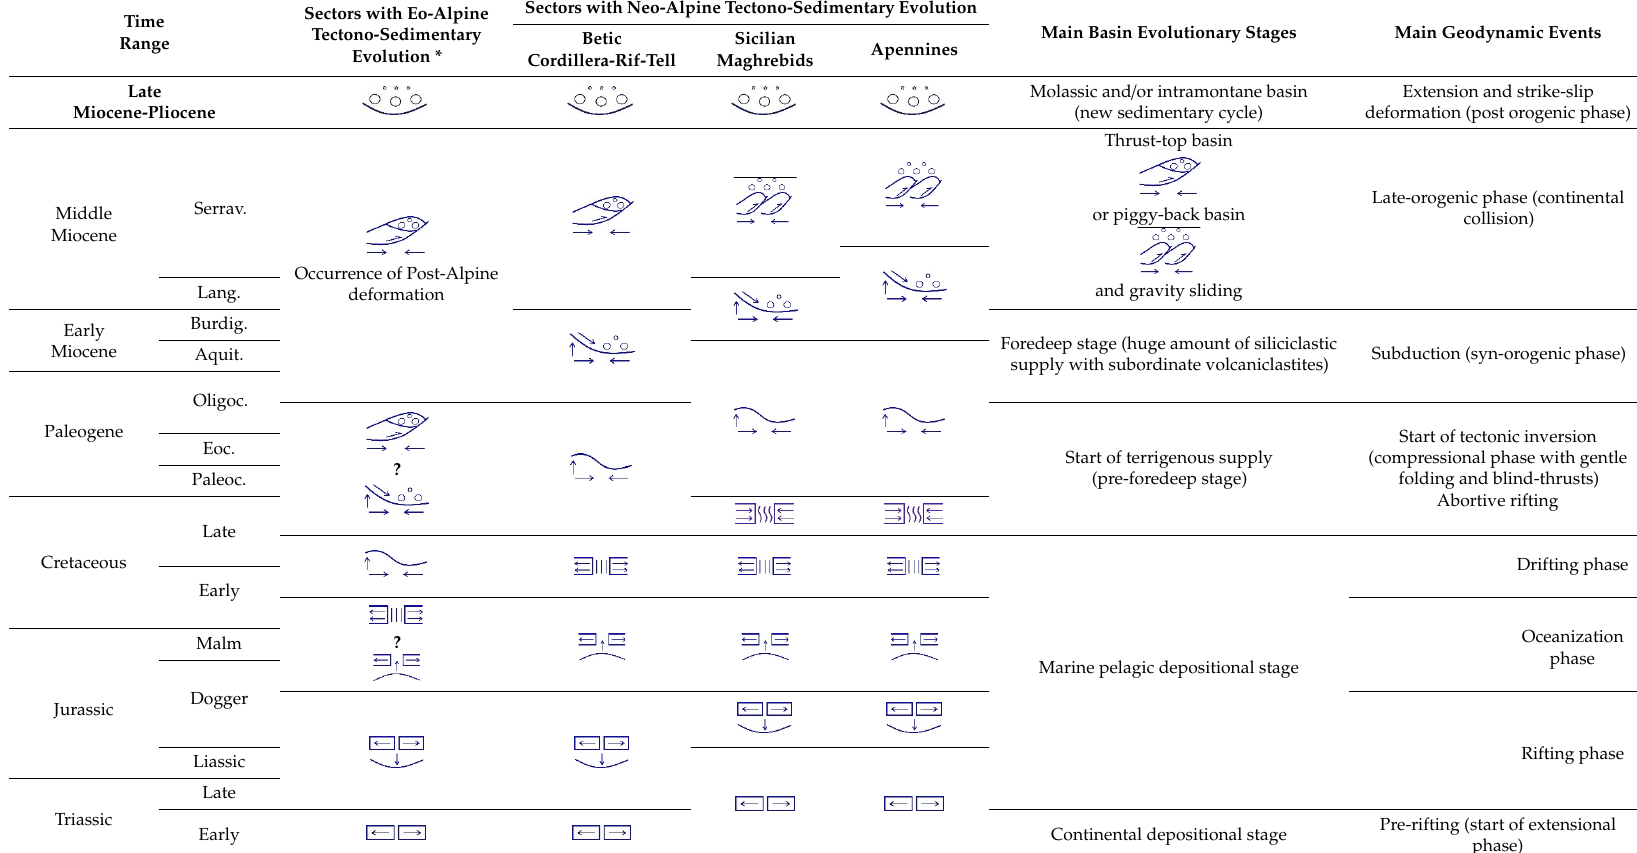
* In the Maghrebian Flysch Basin (MFB) and the Ligurian-Piemontese Ocean for models considering only an ocean between European and African plates); in the Nevado- Filabride and Ligurian-Piemontese Oceans for models considering two oceans at least between European and African plates. Geosciences 2020 , 10 , x; doi: FOR PEER REVIEW